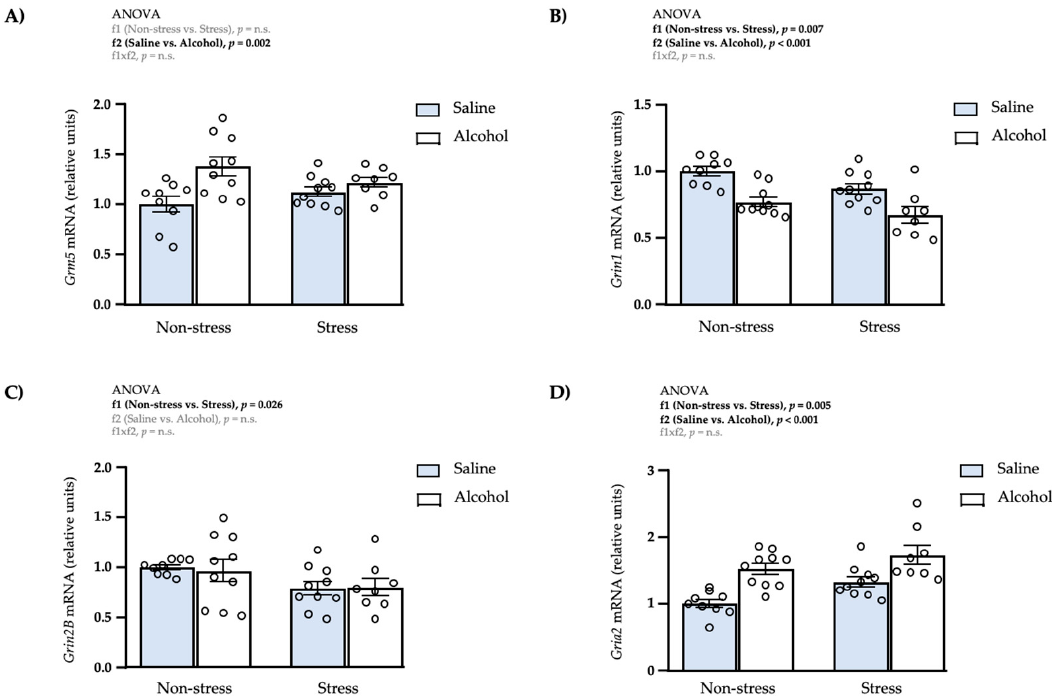
Figure 8. Relative mRNA expression levels of glutamatergic receptor subunits in the mPFC of adult male rats after repeated restraint stress and/or intermittent alcohol exposure during adolescence. Relative mRNA expression of Grm5 ( A ); Grin1 ( B ); Grin2B ( C ); and Gria2 ( D ) in male adult rats after repeated restraint stress (f1) and/or intermittent alcohol exposure (f2) during adolescence. Bars represent the mean ± SEM (8–10 rats/subgroup). Data were analyzed by two-way ANOVA. p -values in bold denote significant main effects of factors (f1 and f2).